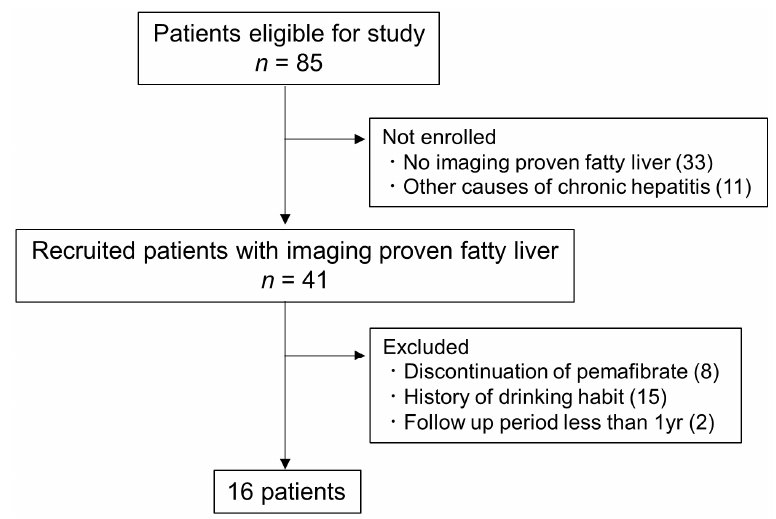
Figure 1. Flowchart of patient selection. Initially, there were 85 eligible patients. Thirty three patients were not enrolled because they had not been proven to have fatty liver through imaging. Patients with other causes of chronic hepatitis were also not enrolled. Patients who stopped pemafibrate for any reason and/or with a history of drinking and short duration of using pemafibrate were excluded from the study. Finally, 16 patients were selected for this study.